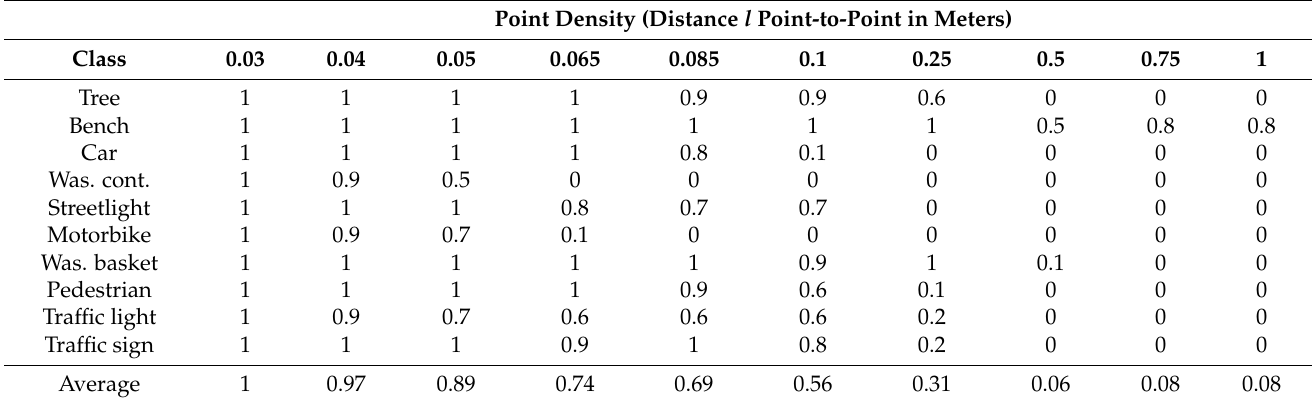
Table 2. Precision of the classification with point density reduction.